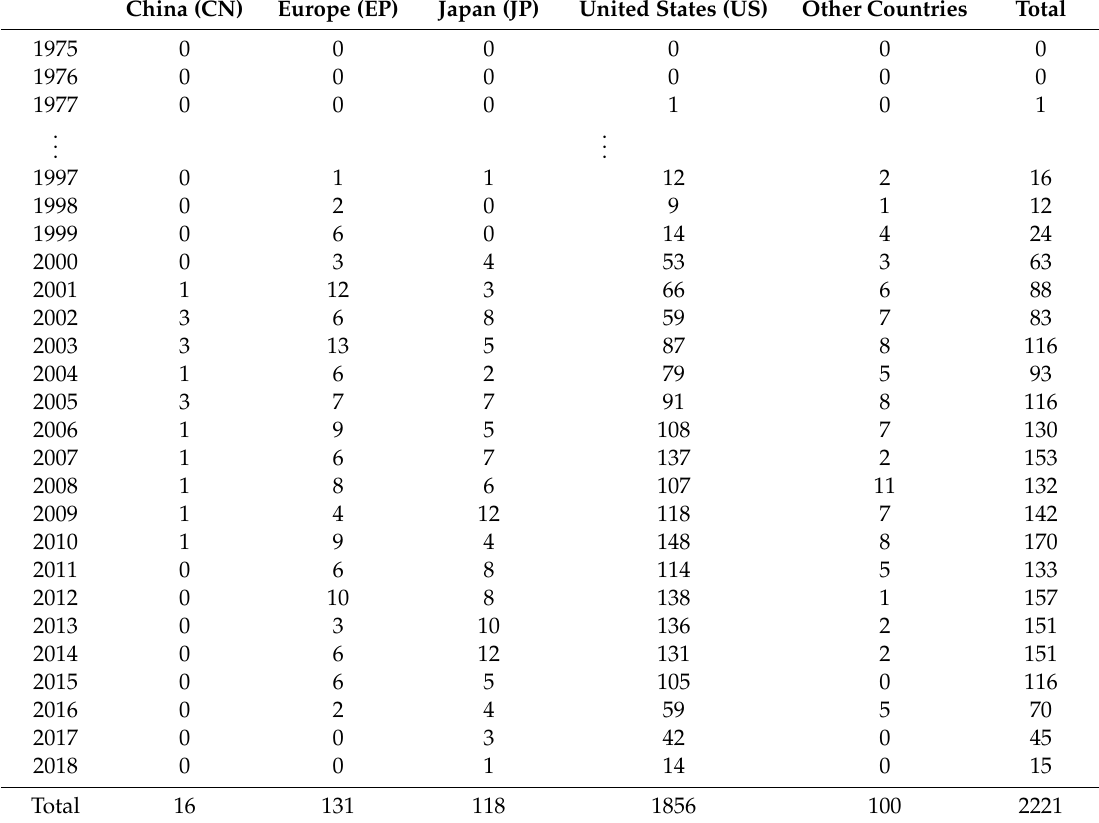
Table 3. Yearly granted patent counts by country